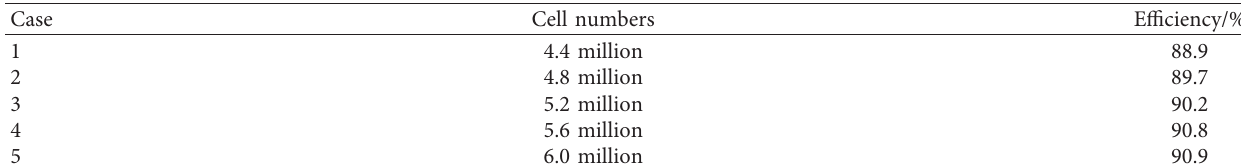
Figure 5: Model diagram of bulb tubular. Table 3: Grid number and unit